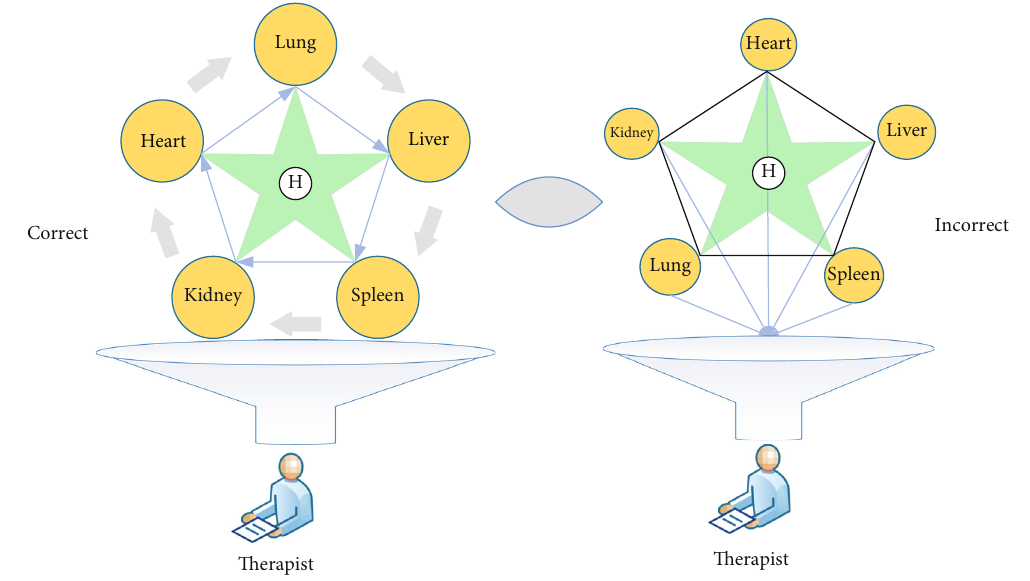
Figure 1: Music therapy di ff